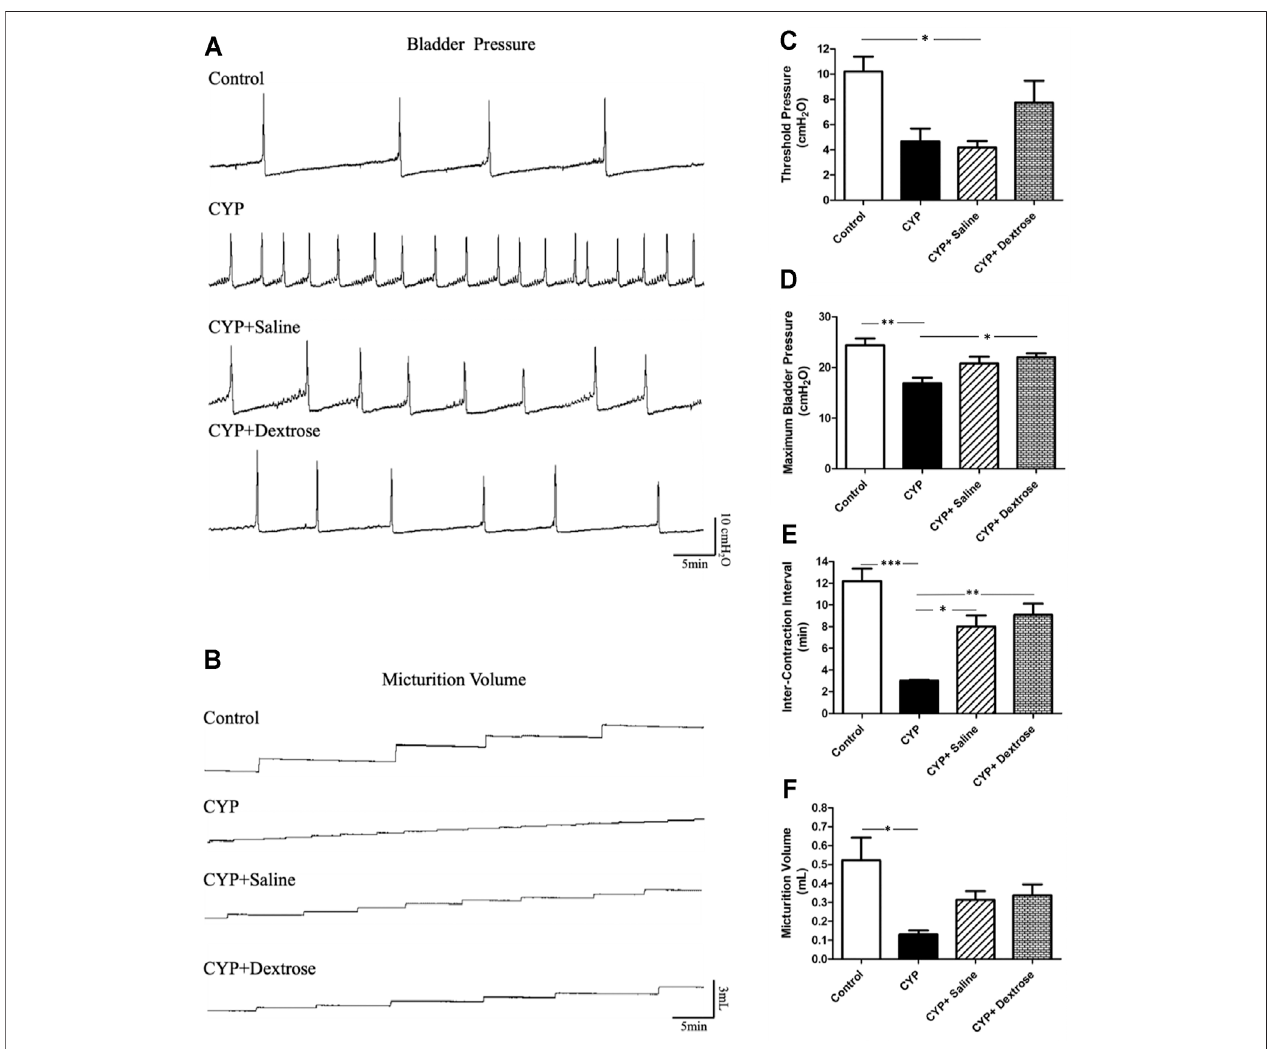
FIGURE 2 | Cystometric voiding parameters of rats with interstitial cystitis in response to treatment. (A) Cystometrogram recordings of bladder pressure; (B) cystometrogram recordings of micturition volume; (C) quantitative of threshold pressure; (D) quantitative of maximum bladder pressure; (E) quantitative of inter- contraction interval; (F) quantitative of micturition volume. (CYP (cid:1) cyclophosphamide; * p ≤ 0.05; ** p ≤ 0.01; *** p ≤ 0.001).